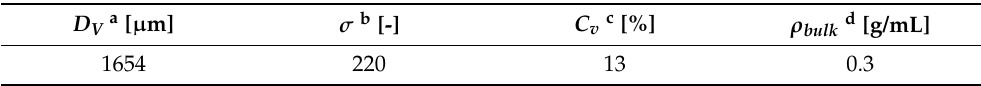
Figure 2. Macroscopic shape of pTrim cryogel particles’ ( a ) appearance; and of ( b ) size distribution of particle diameter. Table 1. Particle properties of pTrim cryogel particles.